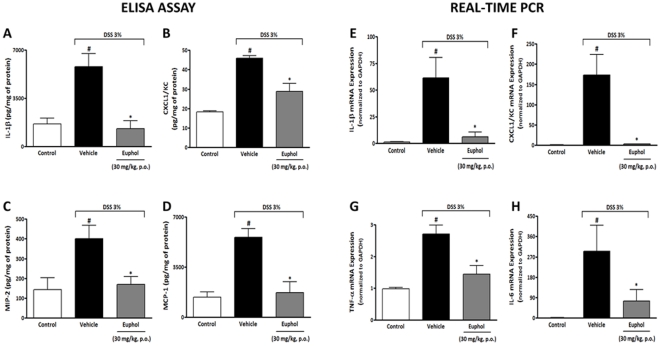
Preventive treatment with euphol changes colonic protein levels and mRNA expression of inflammatory mediators.At the end of 7 days, colon tissue was collected and processed for cytokine levels and mRNA expression. (A–D) Enzyme-linked immunosorbent assay. Preventive treatment with euphol (30 mg/kg, p.o.) reduced colonic levels of interleukin-1β (IL-1β) (A), keratinocyte-derived chemokine (CXCL1/KC) (B), macrophage inflammatory protein-2 (MIP-2) (C) and monocyte chemoattractant protein-1 (MCP-1) (D). (E–H) Real-time PCR. The same scheme of treatment with euphol also impaired the increase colonic mRNA expression of IL-1β (E), CXCL1/KC (F), tumor necrosis factor-α (TNF-α) (G) and interleukin-6 (IL-6) (H). The real-time PCR assay was performed in duplicate and GAPDH mRNA was used to normalize the relative amount of mRNA. Data are reported as means ± S.E.M. of 8 to 10 mice per group and is representative of three independent experiments. #P<0.05 vs. control healthy group (non colitic); *P<0.05 vs. DSS-treated group.